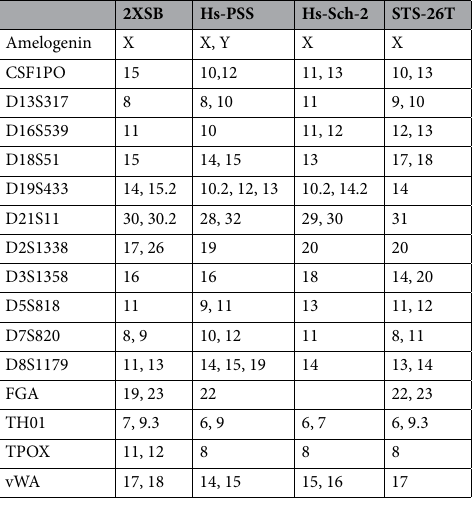
Table 1. Short terminal repeat (STR) profile of the human 2XSB MPNST cell line compared to the STR profiles of the Hs-PSS, Hs-Sch-2 and STS-26T sporadic MPNST cell